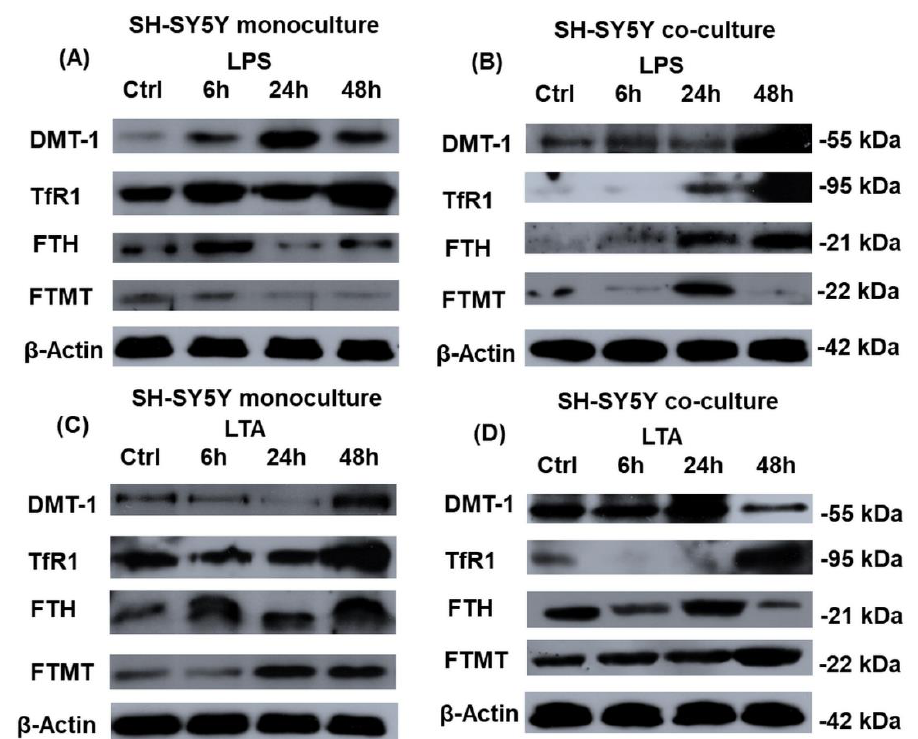
Figure 5. Western blot analyses of proteins involved in iron uptake and storage in mono- ( A , C ) and co-cultured ( B , D ) SH-SY5Y cells. Pelleted cells were lysed and their protein contents were measured. The same amount of protein (15 µg) from each sample was separated by SDS-PAGE using 12% or 14% polyacrylamide gels, transferred by electroblotting to nitrocellulose membranes and probed with anti-DMT-1, anti-TfR1, anti-FTH, and anti-FTMT polyclonal rabbit antibodies according to the manufacturers’ protocols. DMT-1 and TfR1 expressions reflect iron uptake capacity of SH-SY5Y cells. FTH and FTMT protein levels show the mechanisms of iron storage in SH-SY5Y cells. The experiments were repeated at least three times. Optical density analyses can be seen in Figure S1.